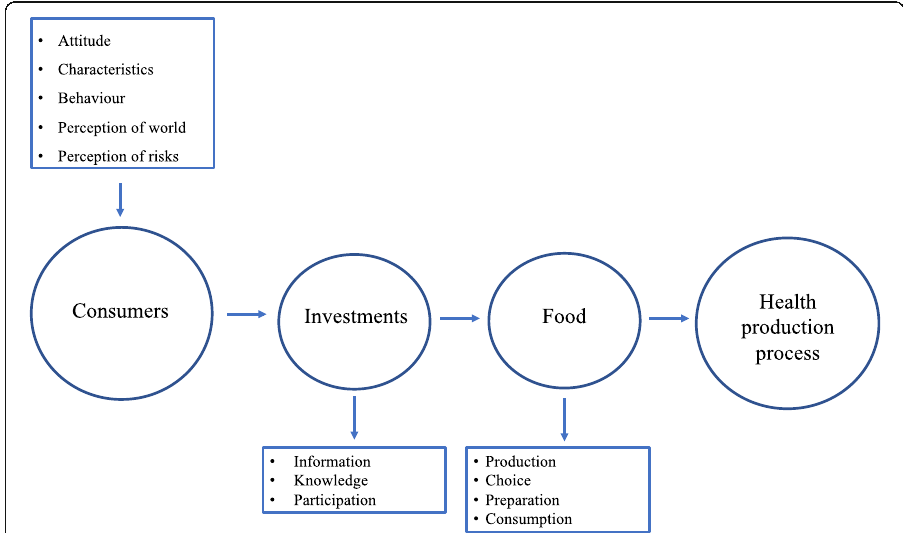
Fig. 1 Consumers ’ health production process framework. Source: authors ’ elaboration on Grossman Hypothesis